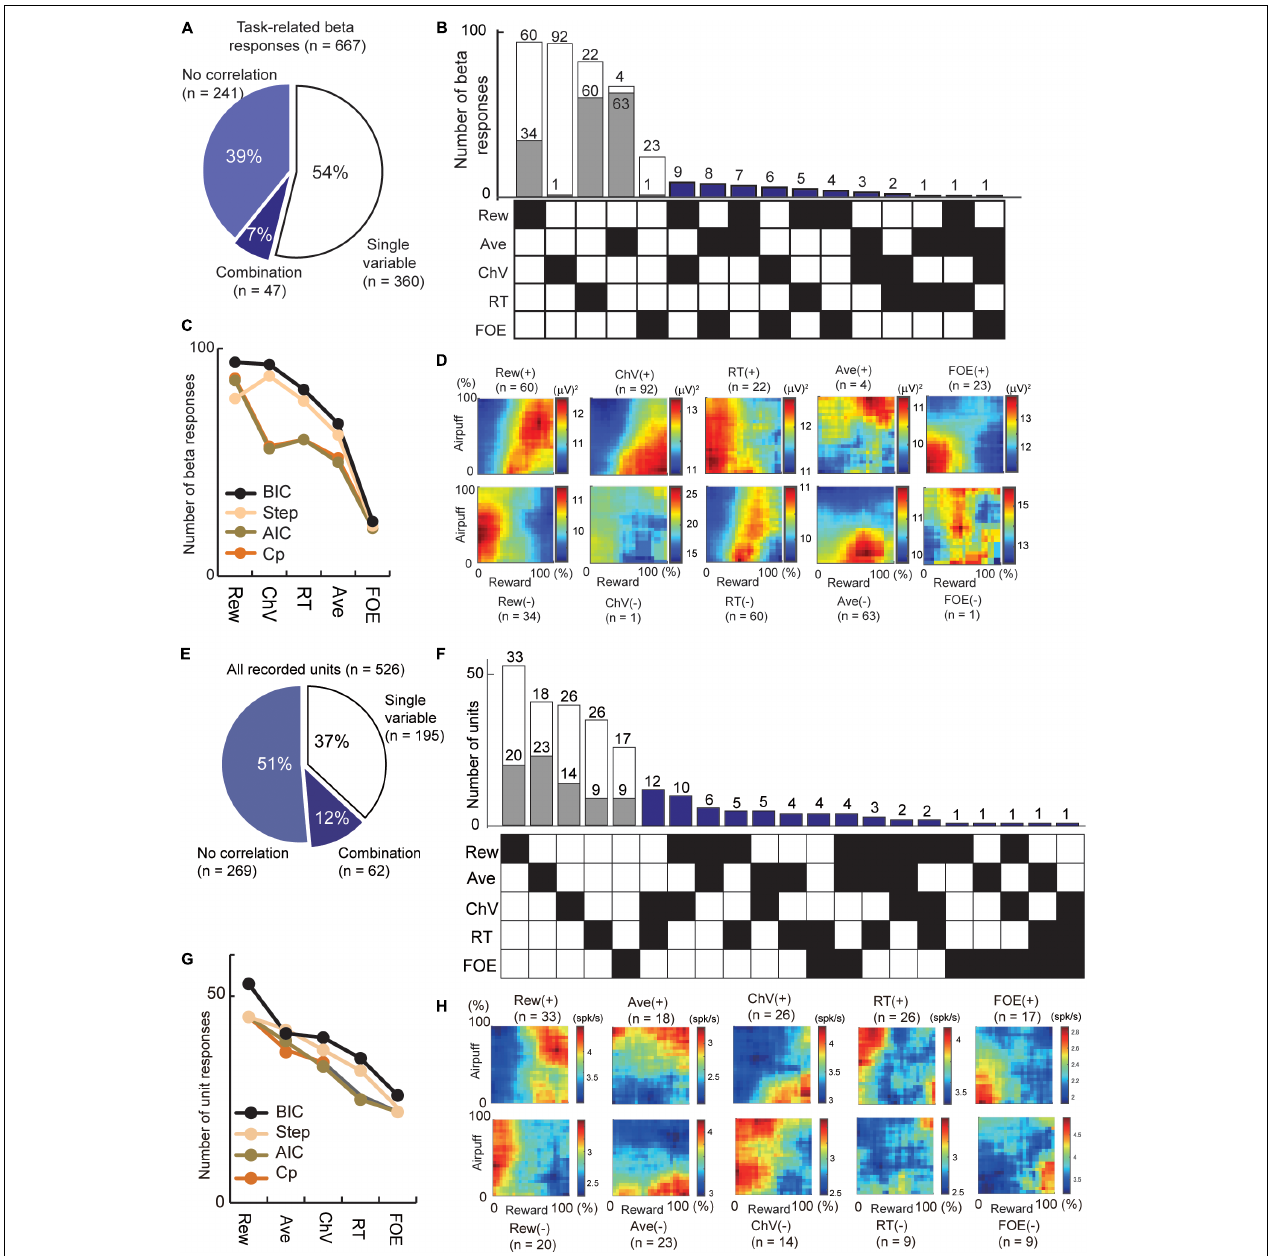
FIGURE 4 | Regression analyses that extract the information encoded by the cue-period beta magnitudes and cue-period unit activities. (A) The number of beta responses classified by all-possible subset regression. The proportion of cue-period beta magnitudes explained by a single (54%) and combination (7%) of variables. (B) All-possible subset regression analysis of beta responses using the five explanatory variables (Rew, Ave, ChV, RT, and FOE), sorted in decreasing order of total number responses explained. The 360 responses explained by single variables were further separated into channels with responses that were correlated positively (white) or negatively (gray) with the variable. Forty-seven beta responses were characterized by particular combinations of variables indicated by black squares in the matrix on the bottom. (C) Classification of beta responses with all-possible subset regression analyses performed with different criteria (black, BIC; brown, AIC; orange, Mallow’s Cp), and stepwise regression analysis (cream). Y -axis is the number of beta responses where the best model was the single variable on the x -axis. (D) The population activity of the beta responses explained by single variables, sorted as in (B) . Those correlated positively ( + ) and negatively ( − ) with the variables were separately categorized. (E) The number of unit activities classified by all-possible subset regression. The proportion of the cue-period unit activities explained by a single (37%) and combination (12%) of variables. (F) All-possible subset regression analysis of unit responses using the five explanatory variables (Rew, Ave, ChV, RT, and FOE), sorted in decreasing order of total number responses explained. The cue-period unit activities of 195 units were explained by single variables and were further separated into channels with responses that were correlated positively (white) or negatively (gray) with the variable. The activities of 62 units were characterized by particular combinations of variables indicated by black squares in the matrix on the bottom. (G) Classification of units with different criteria as in (C) (black, BIC; brown, AIC; orange, Mallow’s Cp; stepwise regression analyses, cream). (H) The population activity of the unit responses explained by single variables, sorted as in (F) . Those correlated positively ( + ) and negatively ( − ) with the variables were separately categorized.